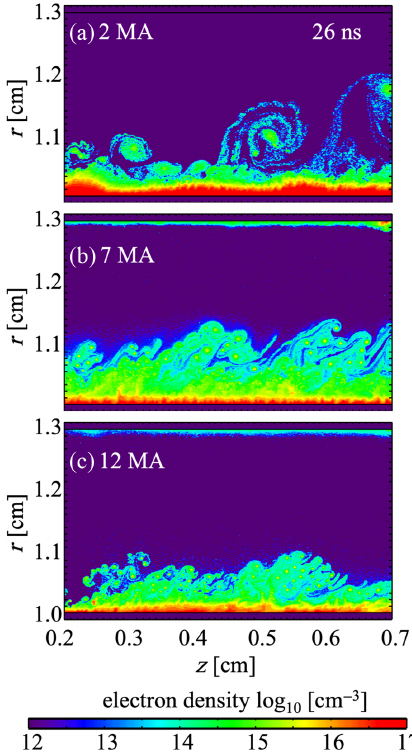
FIG. 6. The electron temperature contours corresponding to the densities in Fig. 5. The same 5-mm segment of the Fig. 1(b) simulation is used and the currents at 26 ns are (a) 2, (b) 7, and (c) 12 MA for the three pulse rises. Temperatures are plotted on a log scale from 10 − 2 − 10 3